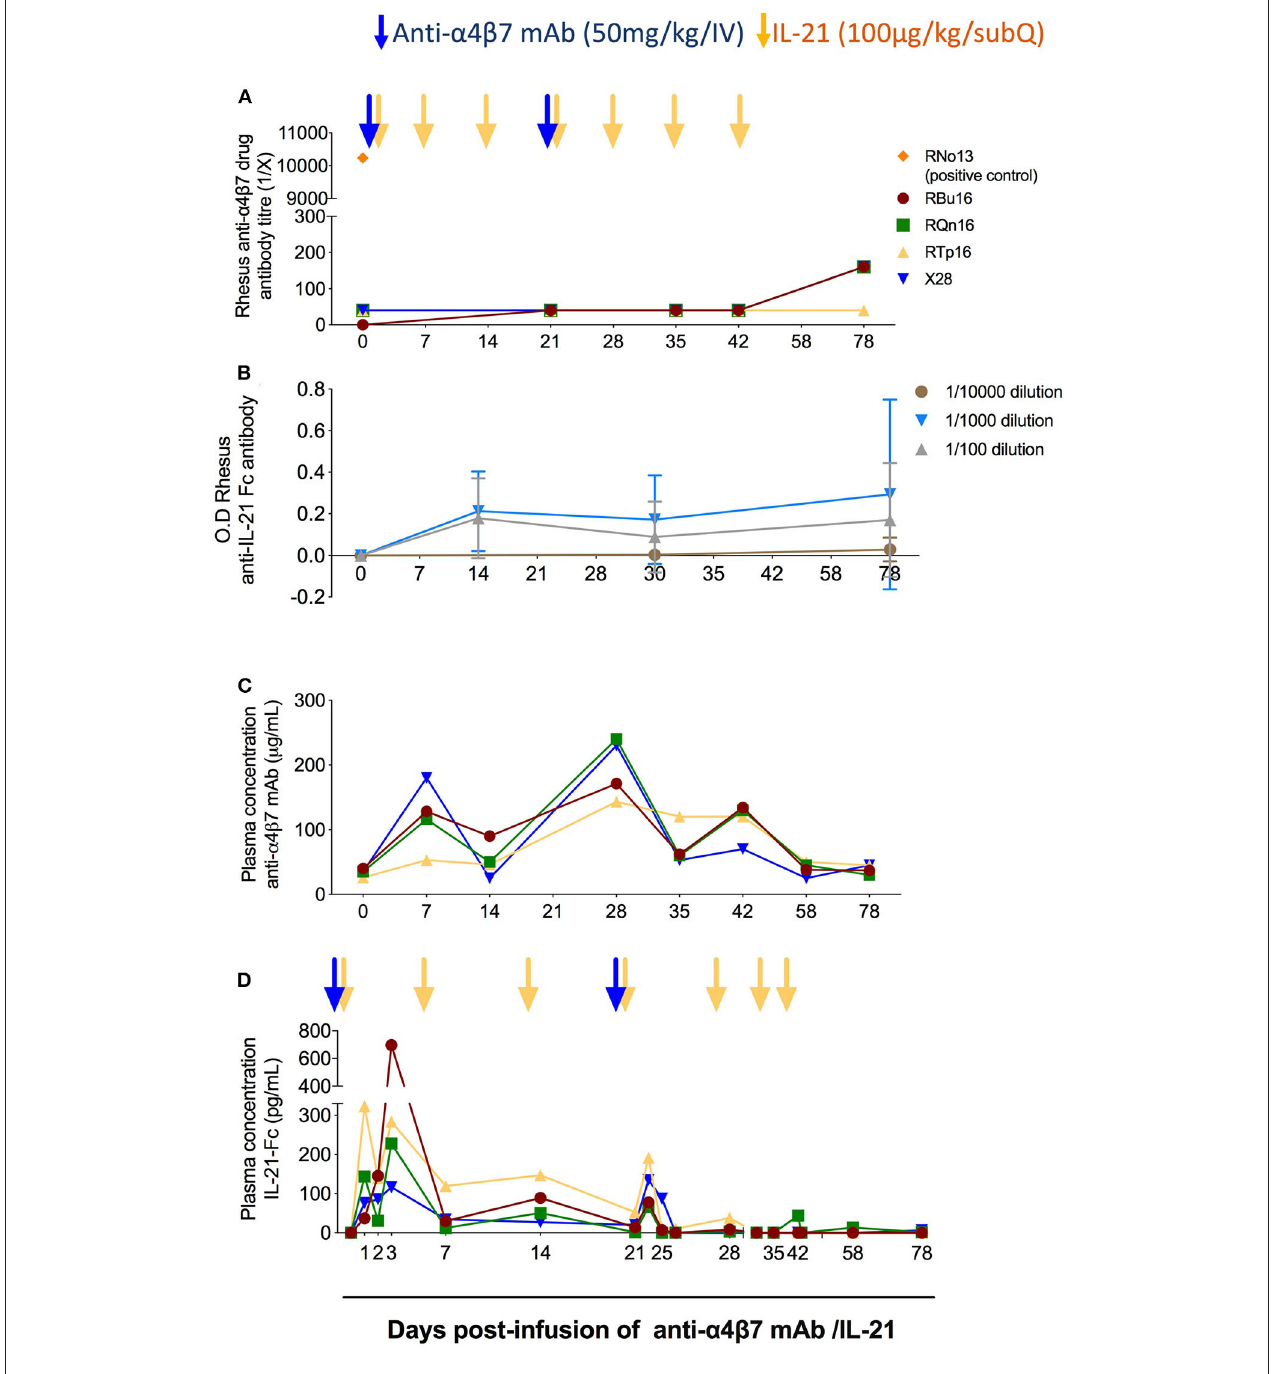
FIGURE 2 | Co-administration of anti- α 4 β 7 mAb and IL-21 does not elicit reactive antibodies . (A) Analysis of rhesus antibodies anti- α 4 β 7 mAb in plasma at different time points. The anti-drug antibodies levels were measured by ELISA end point titer method as described in the Materials and Methods section. RNo13, indicated in orange, corresponds to the plasma of an animal from a previous study that developed ADAs (21), and it was used as a positive control. (B) Measurement of anti–IL-21–Fc antibodies in plasma at different time points. Anti–IL-21–Fc antibodies were measured by ELISA longitudinally until the end of the study with three different dilutions (1:100, 1:1,000, and 1:10,000). (C) Measurement of anti- α 4 β 7 mAb plasma levels ( µ g/mL) in RMs ( n = 4). The assay was performed using flow cytometry with HuT 78 cells. The levels of anti- α 4 β 7 mAb were measured employing standard curve method. Mean fluorescence intensity (MFI) of known concentration of anti- α 4 β 7 mAb was obtained, and then the MFI of plasma levels of anti- α 4 β 7 mAb was plotted. (D) Measurement of IL-21–Fc plasma levels (pg/mL) in RMs ( n = 4). ELISA background and plasma baseline values were subtracted from the values analyzed at each time point. Individual animals are represented with different colors and symbols. Blue arrows indicate the anti- α 4 β 7 mAb intravenous infusions, and yellow arrows indicate IL-21 subcutaneous infusions.